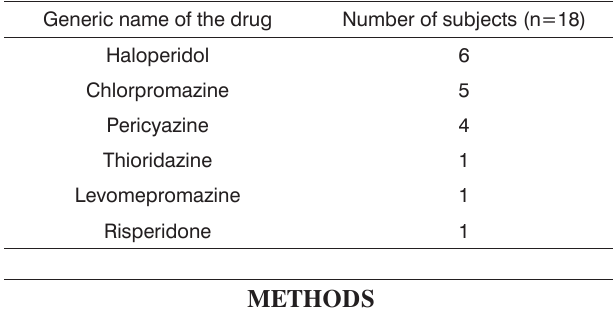
Table 1. Prescribed neuroleptic